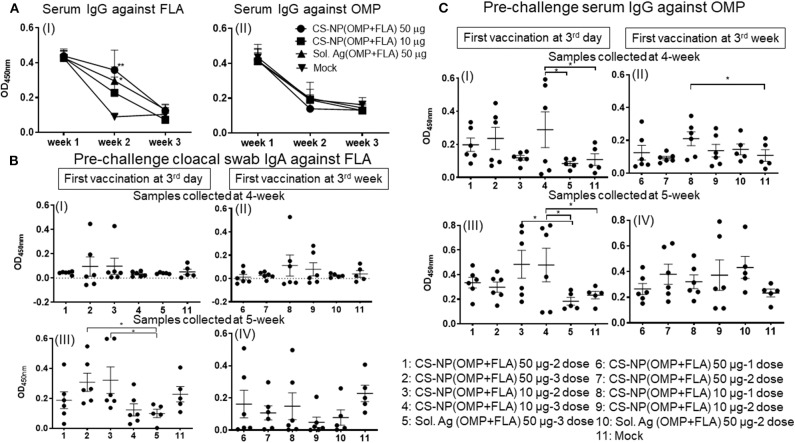
Salmonella specific antibody response post-vaccination and before challenge infection. Broiler birds were vaccinated with CS-NP(OMP+FLA) orally beginning at age 3-day or 3-week, with each dose containing either 10 or 50 μg OMP+FLA. Control birds received 50 μg of Sol.Ag(OMP+FLA). Cloacal swab and blood samples collected at different time points post-vaccination were analyzed for detection of specific IgA or IgG antibodies by ELISA. (A) Serum samples collected at age 3-day (week 1, before 1st vaccination), week 2 and week 3 were analyzed for IgG response against (I) FLA and (II) OMP. Significant difference between vaccinated and mock groups was analyzed by two-way ANOVA followed by Tukey post-hoc test. (B) Birds received 1st dose of vaccine at 3rd day (I and III) or at 3rd week (II and IV). Cloacal swabs collected at age 4-week (I and II) and 5-week before SE challenge infection (III and IV) were analyzed for IgA antibody response against FLA protein. (C) Serum samples collected on the same days as described in (B, I–IV) were analyzed for IgG antibody response against OMP. Significant difference between the indicated two groups was determined by one-way ANOVA followed by Tukey post-hoc test. *P < 0.05, **P < 0.01. Data were presented as mean ± SEM of 6 or 5 birds.